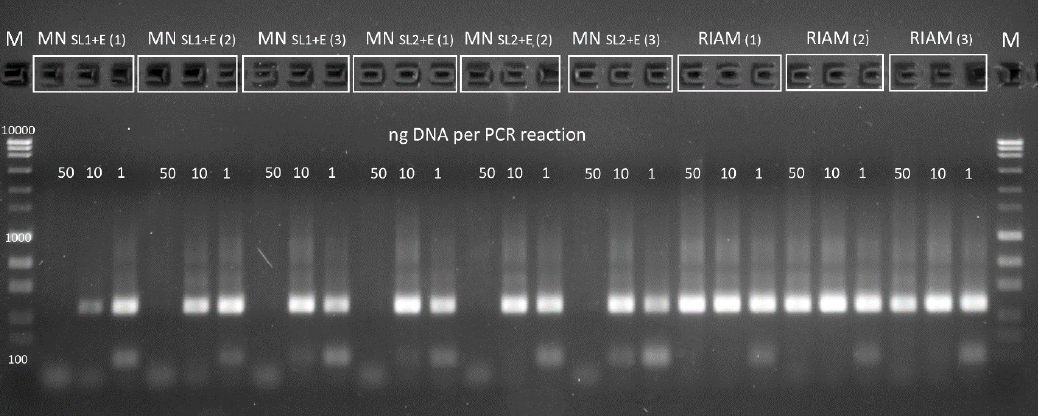
Figure 3. PCR-inhibition effect of 1, 10 and 50 ng DNA isolated with different protocols from OMUG (fertilizer with a high content of humic substances). DNA isolated from other soils using the MN and RIAM protocols did not inhibit